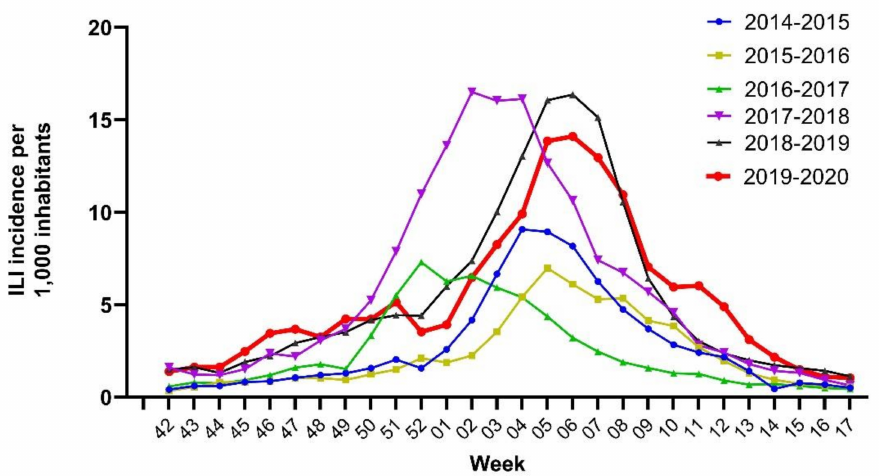
Figure 3. Trends of ILI incidence (per 1000 inhabitants) by week of sample collection and by